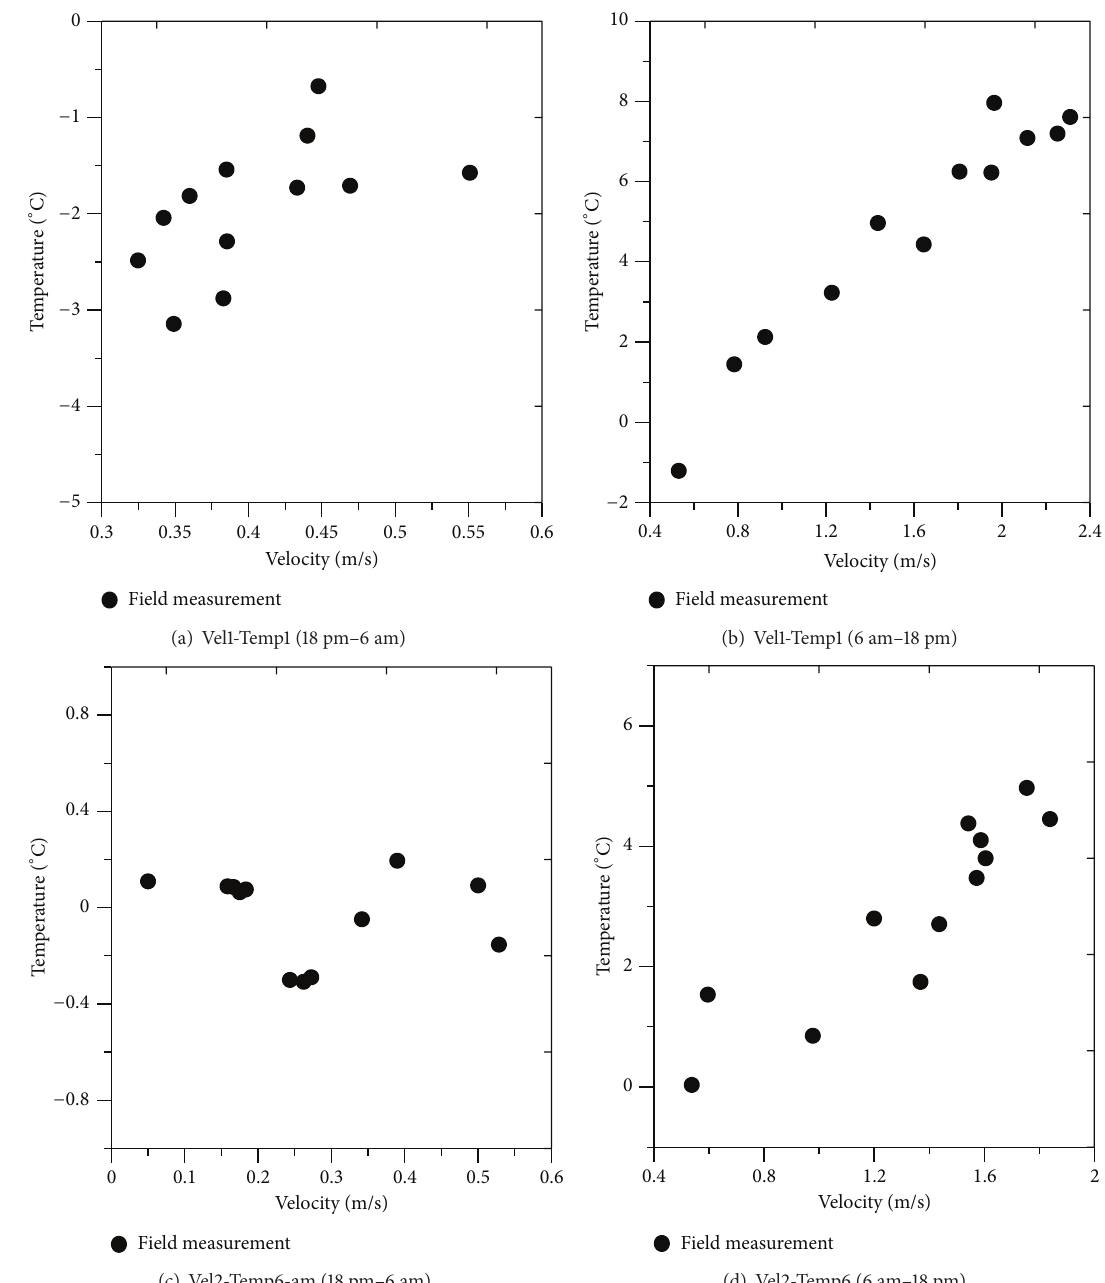
Figure 14: Distribution between wind velocity and temperature by time